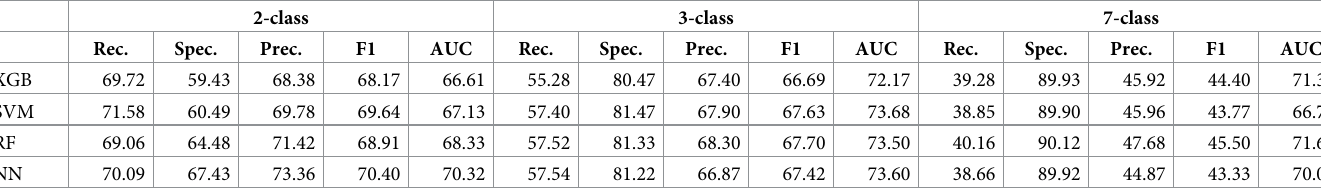
F1 = F1 score; AUC = area under the ROC curve.